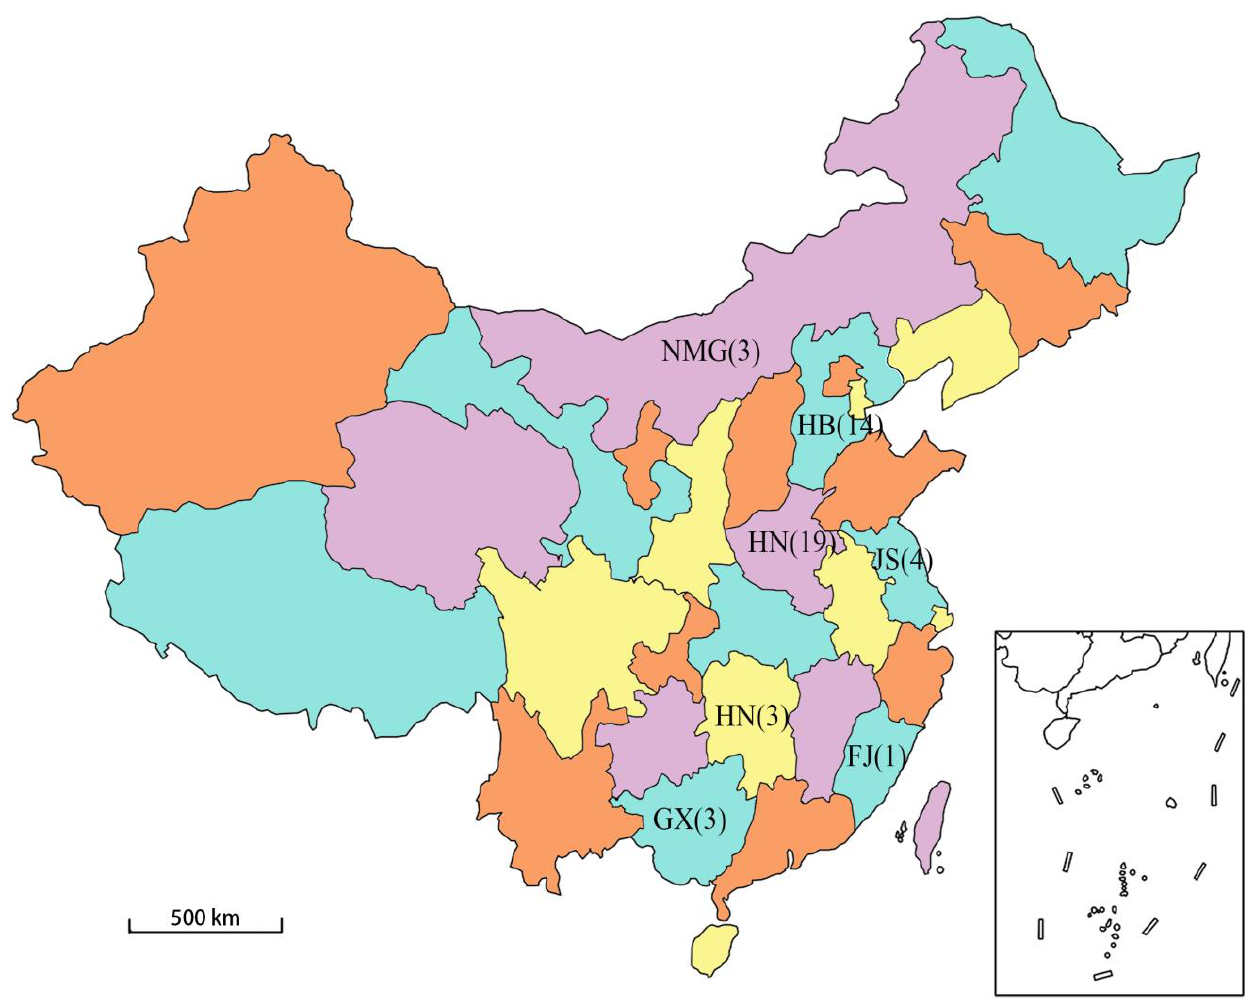
Figure 1. Geographical distribution map of the domestic PCV4 strains collected (The different colors in the figure have no special meaning, only to distinguish between the adjacent regions). The abbreviation indicates the name of the region, and the numbers indicate the number of PCV4 strains collected in China (41). Table 1. The designations, clinical signs, genotypes, GenBank accession numbers and other charac- teristics of the PCV4 strains used in the present study.